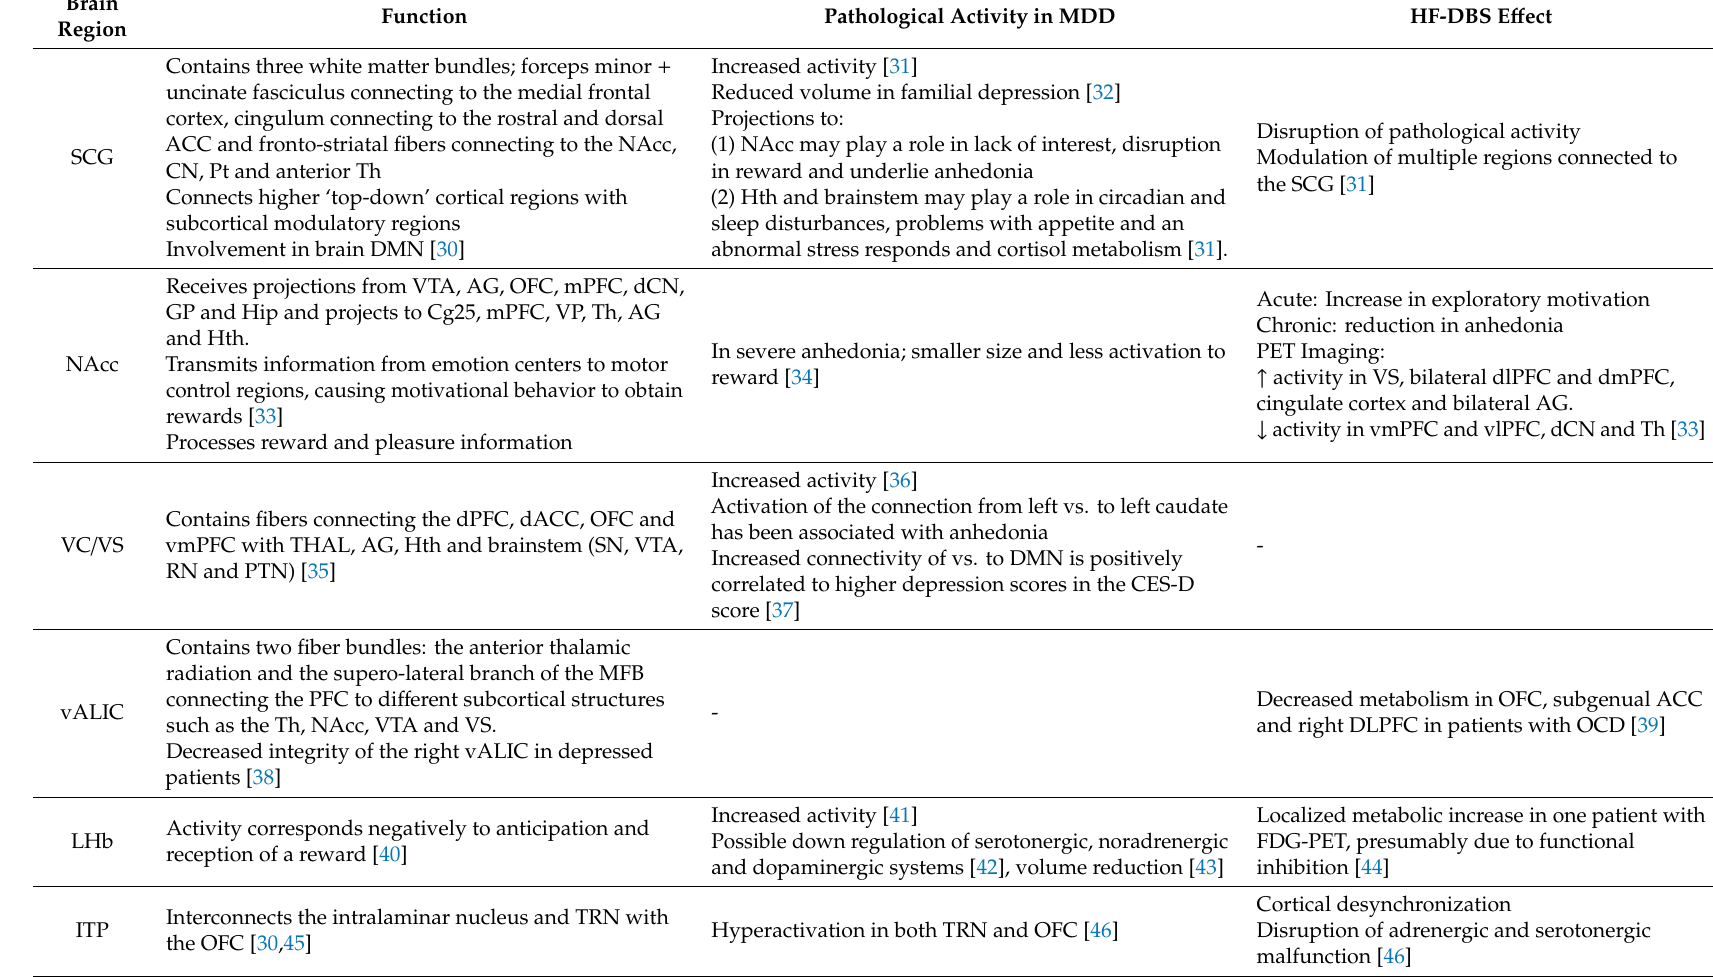
Table 2. Targets for DBS in treatment resistant depression (TRD), functions, pathophysiology and the e ff ect of DBS.